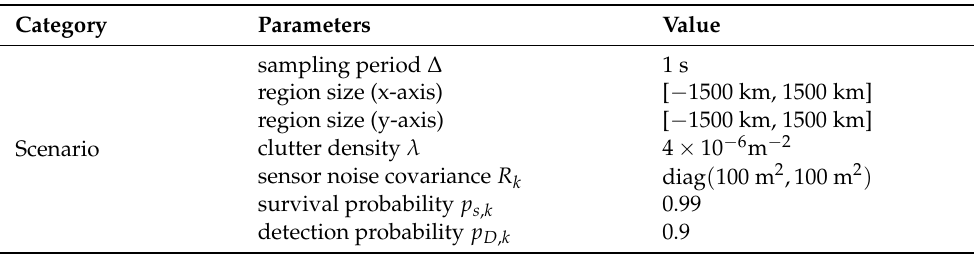
Table 2. The Settings of the Simulation Scenario.